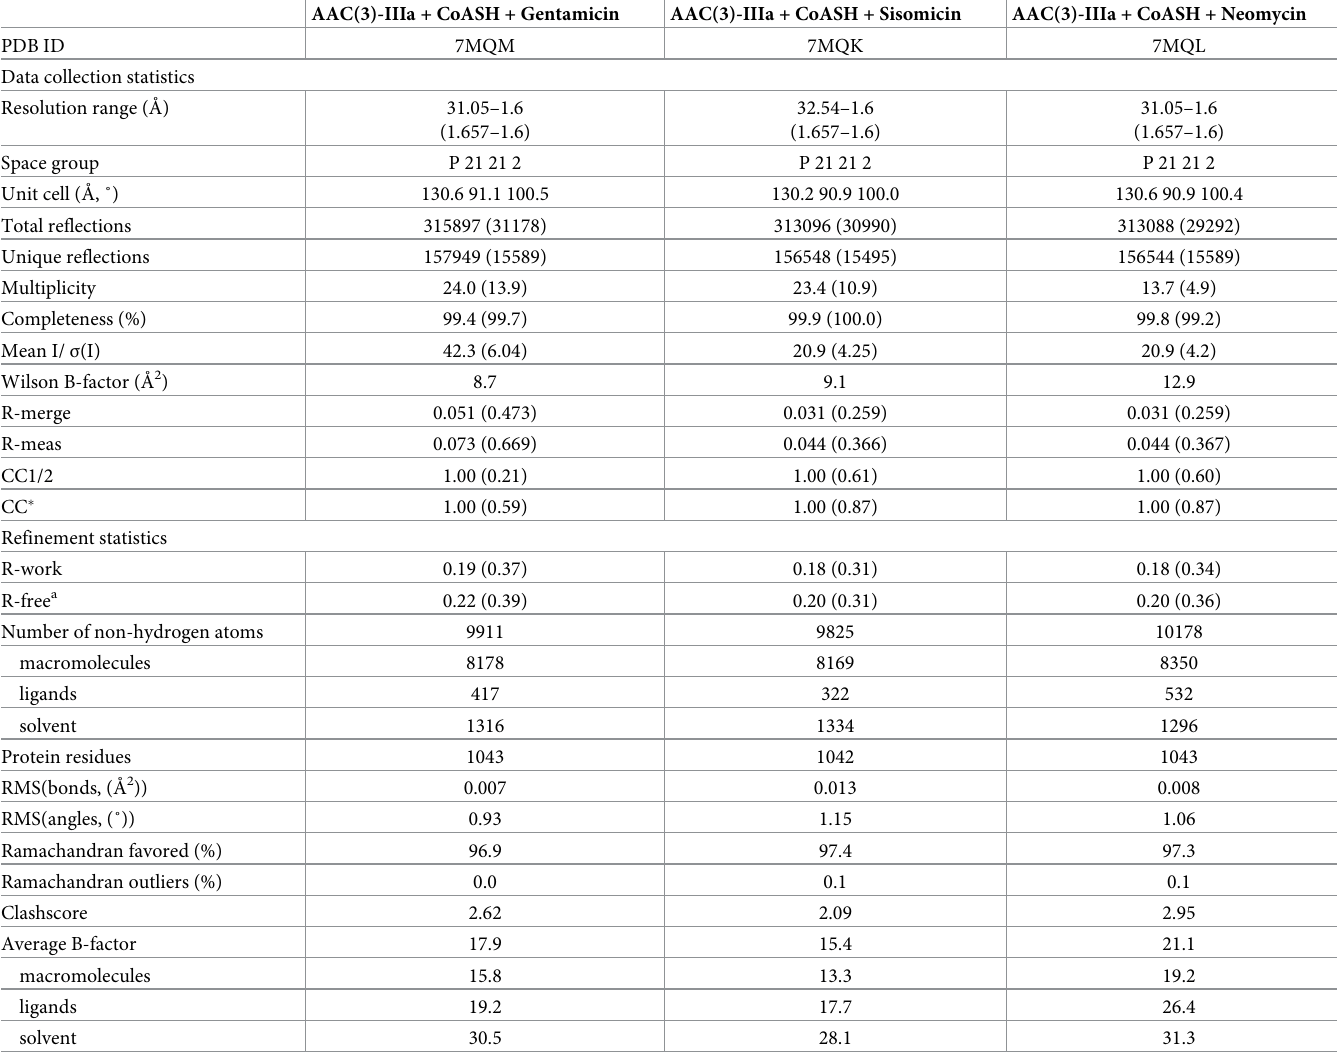
Table 2. Data collection and refinement